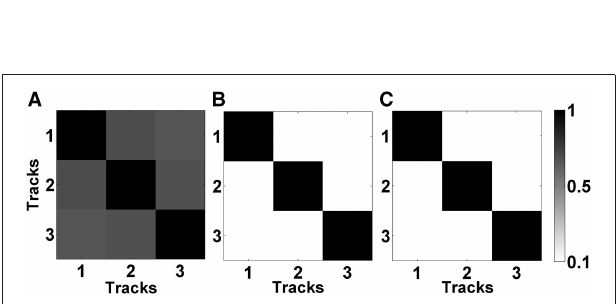
FIGURE 5 | Correlation matrices of raw and de-correlated data. (A) The correlation matrix of raw data in beta band (11–32Hz). All three tracks show high correlation. (B) The correlation matrix of raw data in HFO band (200–450Hz). Small correlation between tracks indicate spatially more localized HFOs. (C) The correlation matrix of subband-decorrelated data. All three tracks demonstrate a small correlation indicating spatio-spectrally distinguished